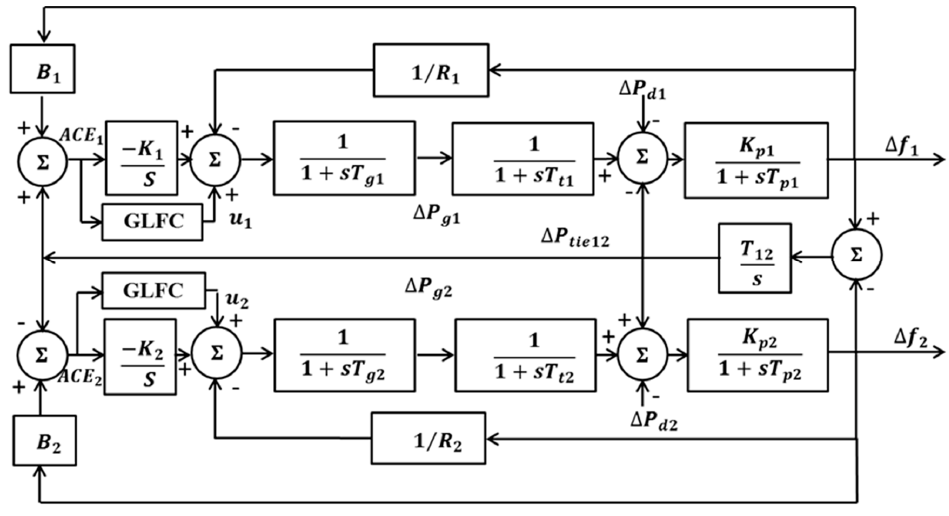
Figure 1. An incremental linearized model of two-area power systems.